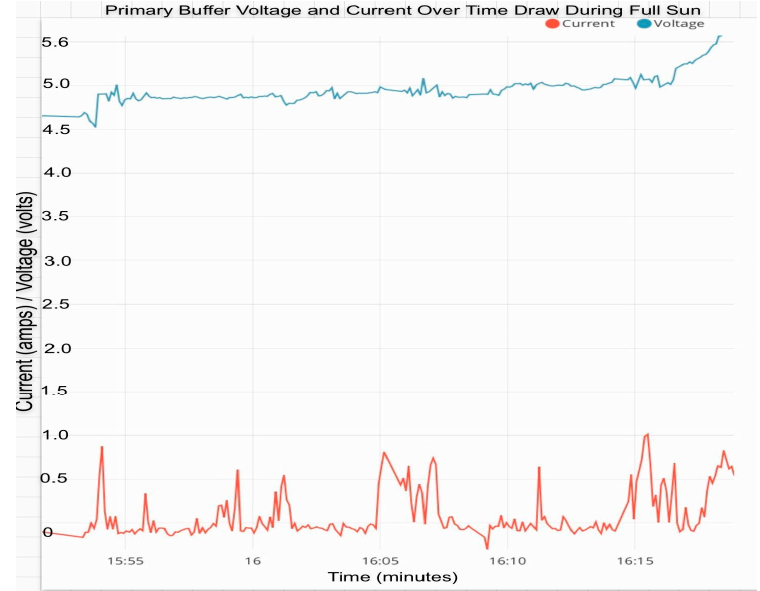
Figure 4. Rover outdoor test under direct sunlight.